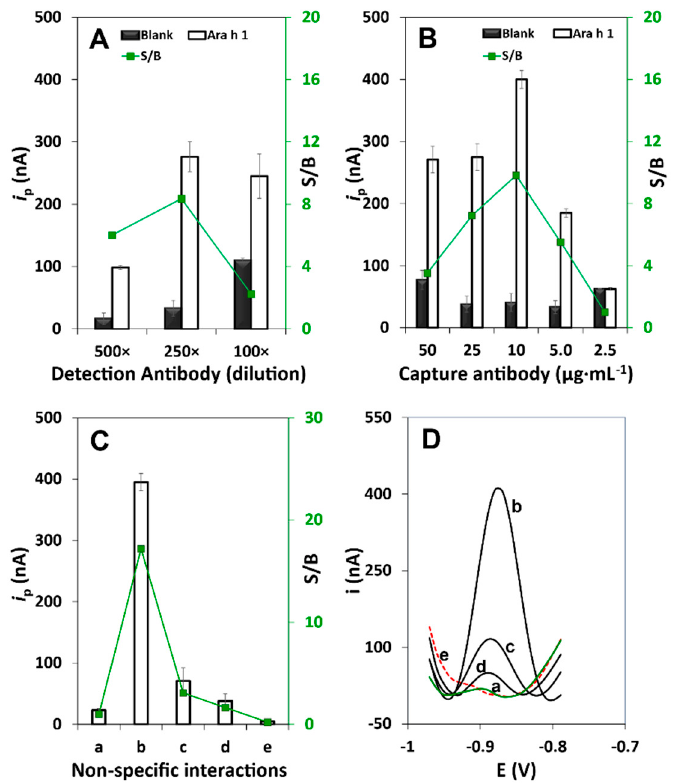
Figure 3. Obtained i p values by DPASV in the absence (“B”, 0 ng · mL − 1 ) and in the presence (S, 250 ng · mL − 1 ) of Ara h 1 and the corresponding S/B ratio value for the optimization of ( A ) DAb dilution factor and ( B ) CAb concentration. ( C ) Study/evaluation of non-specific interactions and biosensor performance for the optimized and complete immunoassay: i p values obtained in the ( a ) absence of Ara h 1 and ( b ) presence of Ara h 1 (control assays), and in the presence of Ara h 1, but in the absence of ( c ) CAb, ( d ) DAb, ( e ) QDs. ( D ) The corresponding DPASV voltammograms. (Experimental conditions: CAb 10 µg·mL − 1 , 250× DAb dilution in Tris BSA 1.0% (m/V)). Other conditions: QDs 5.0 nM + BSA 2.0% (m/V).